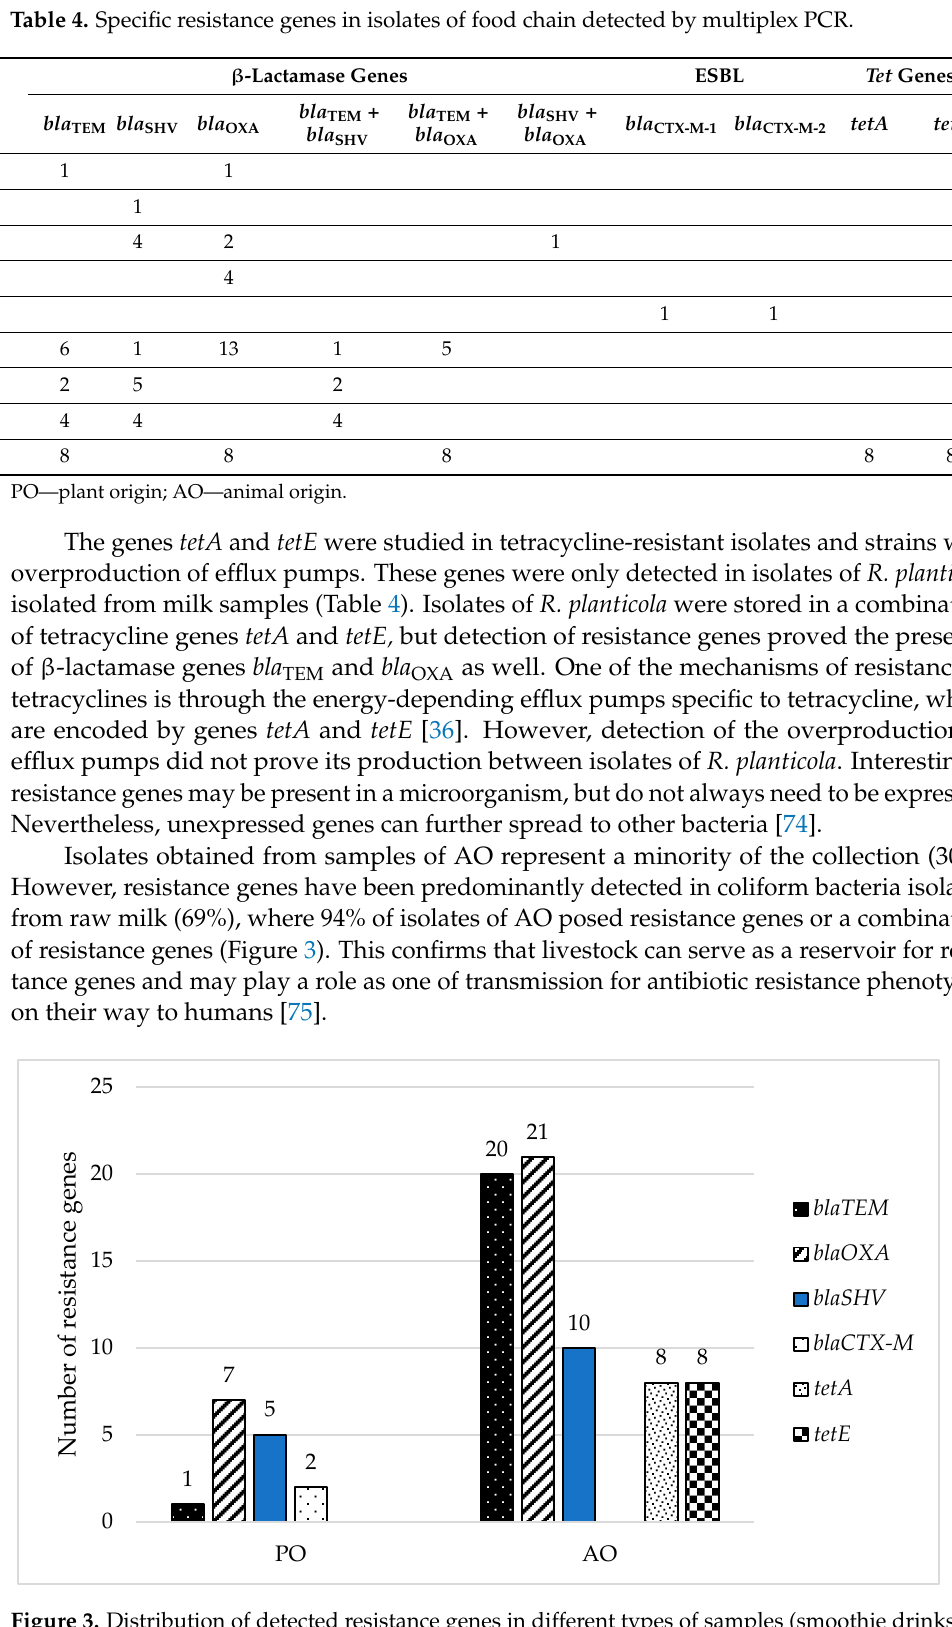
Figure 3. Distribution of detected resistance genes in different types of samples (smoothie drinks-PO and raw milk-AO).